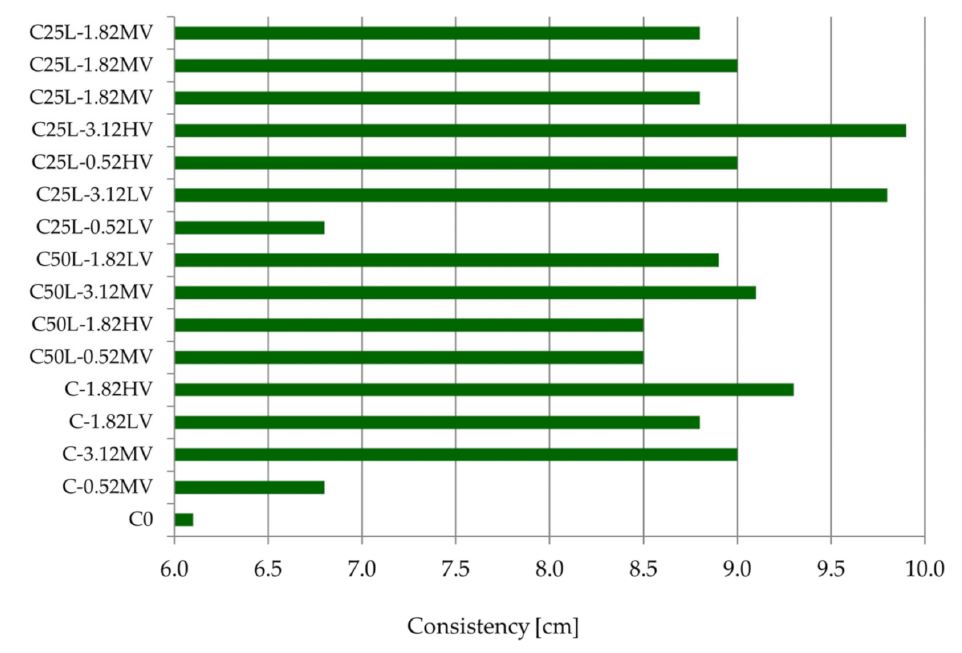
Figure 3. Consistency results of mortars according to